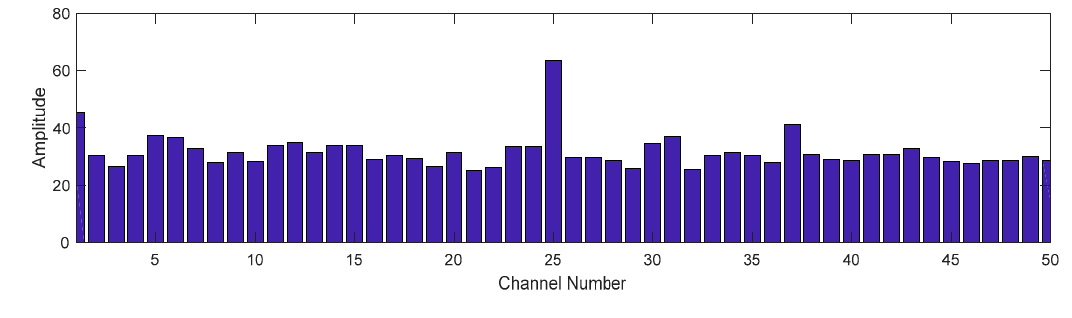
Figure 9. Channel estimation.